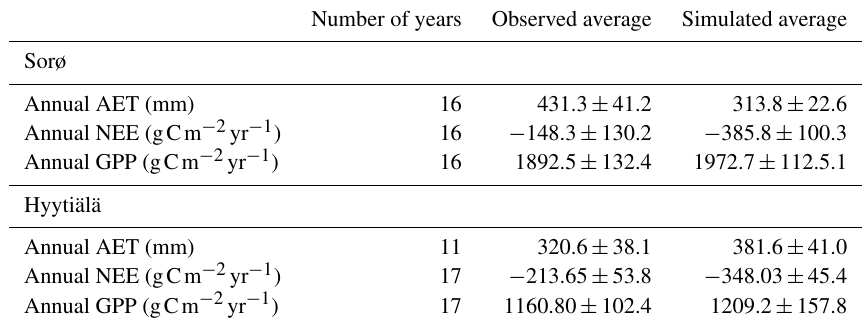
Table 5. Evaluation metrics for daily, monthly, and annual sums of AET, NEE, and GPP for Sorø (1996–2012) and Hyytiälä (1996–2014). Daily Monthly Number NRMSE ME R 2 of days